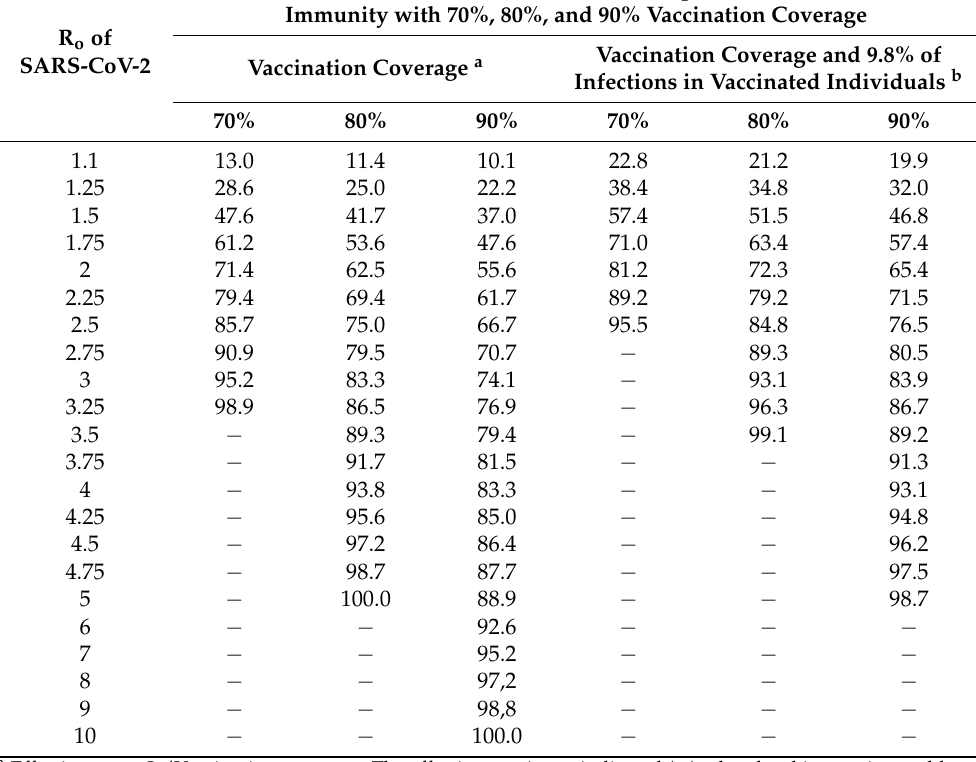
Table 4. Vaccination effectiveness necessary to establish herd immunity against SARS-CoV-2 with the basic reproduction number ranging from 1.1 to 10 in populations with percentages of vaccination coverage of 70%, 80%, and 90%, with 0% and 9.8% of infections among vaccinated individuals. COVID-19 Vaccination Effectiveness (%) Required to Establish Herd Immunity with 70%, 80%, and 90% Vaccination Coverage R o of Vaccination Coverage and 9.8% of SARS-CoV-2 Vaccination Coverage a Infections in Vaccinated Individuals